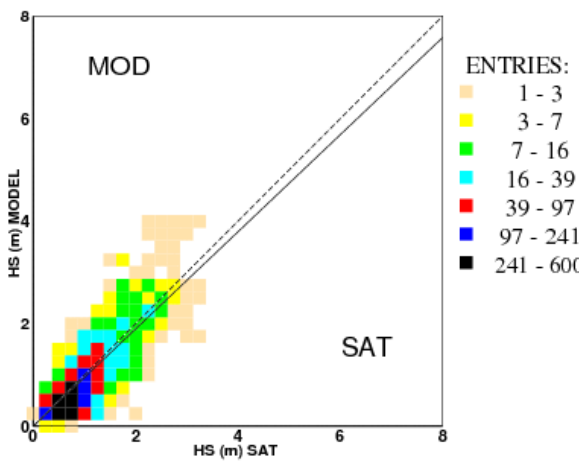
Fig. 11. As Fig. 9, but for the northern Adriatic Sea (see Fig. 10). Figure 11 – As Figure 8, but for the Northern Adriatic Sea (see Figure 10). The total number of data The total number of data is is 3,927.